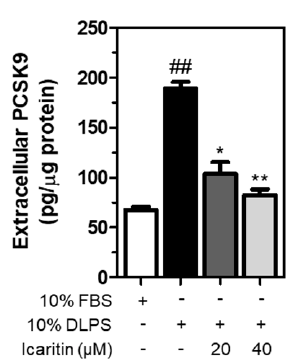
Figure 5. HepG2 cells were treated with FBS or DLPS in the presence of icaritin (0, 20, 40 µM), and extracellular PCSK9 was measured using ELISA. #; significant difference between cells treated with FBS and DLPS (Student’s t -test, ## p < 0.01). *; significant difference between cells treated with DLPS and compounds (Student’s t -test, * p < 0.05; ** p < 0.01).